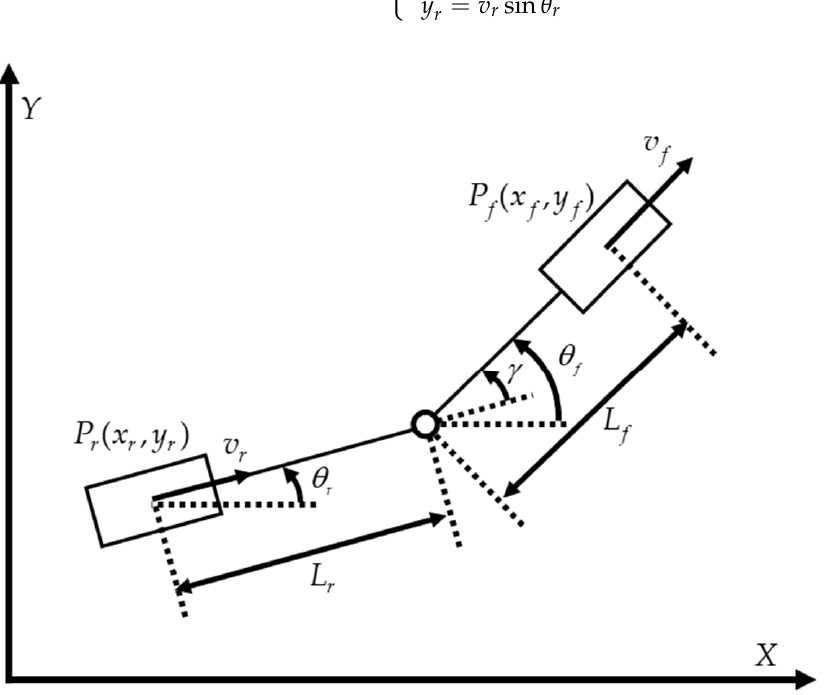
Figure 3. Kinematic model for the AAEV. The front and rear bodies are connected by the rigid articulation joint. Therefore, the change rate of v f and v r is identical. v f and v r can be represented by other variables such as (3) and (4). In addition, the yaw rate of each body and articulation angle rate have the relationship seen in (5)